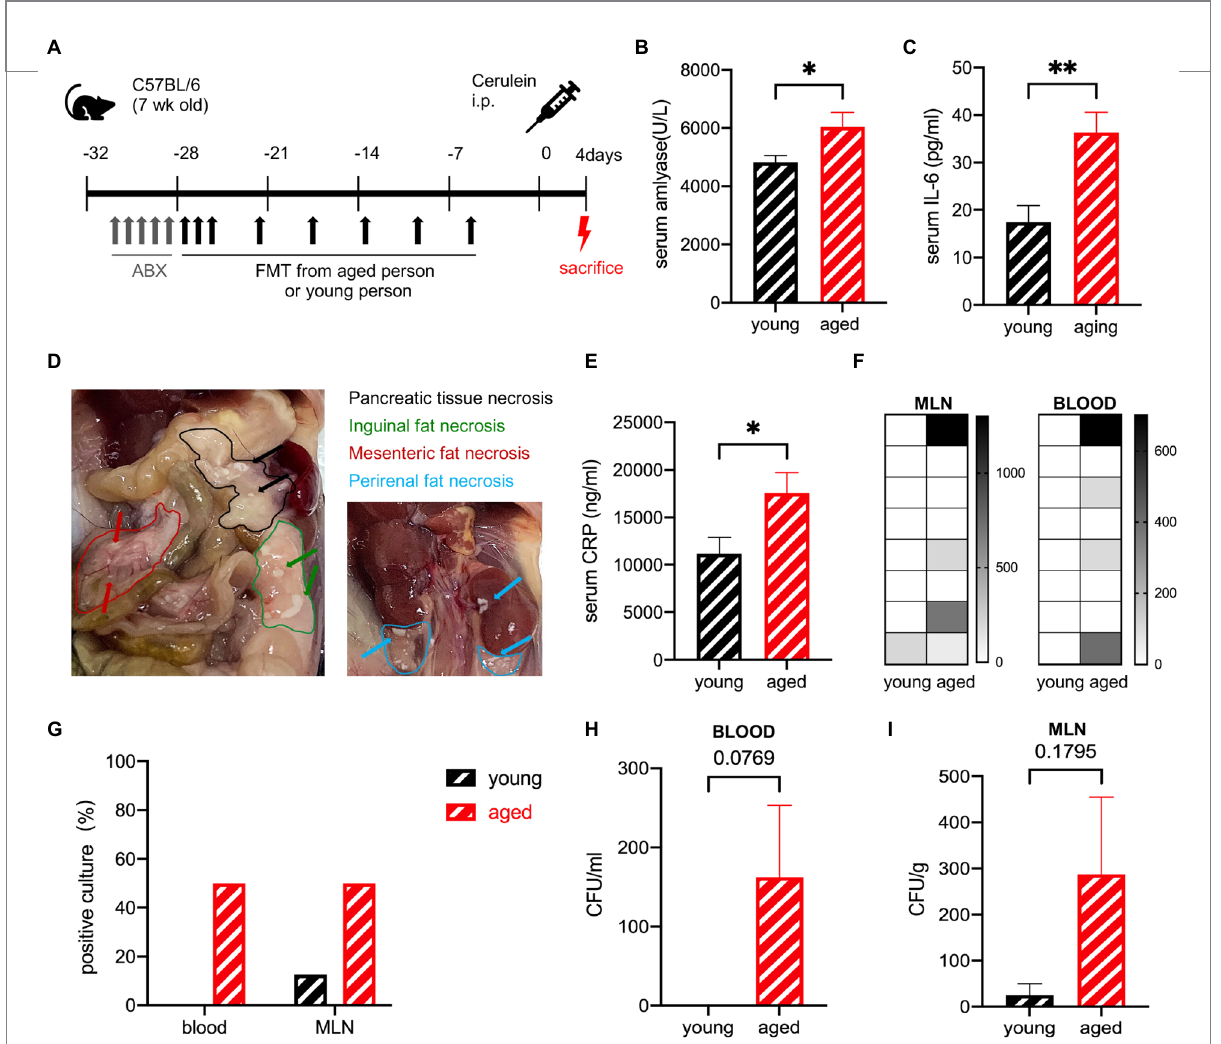
FIGURE 4 (A) Mouse model of severe acute pancreatitis. (B) Serum amylase levels are significantly increased in the old group ( n = 9) compared to the young group ( n = 10). (C) Serum IL-6 levels are significantly increased in the old group ( n = 8) compared to the young group ( n = 8). (D) Pancreatic and extra pancreatic fat necrosis in mice in the old group on day 4. (E) Serum CRP levels are significantly increased in the old group ( n = 8) compared to the young group ( n = 8). (F) Heatmap of the CFU(log2) of blood and MLN ( n = 8). (G) Frequency of culture positivity in blood and MLN ( n = 8 per group). CFU ( n = 8 per group) in the blood (H) and MLN (I) . * p < 0.05, ** p < 0.01, *** p < 0.001, **** p < 0.0001, ns, no significant